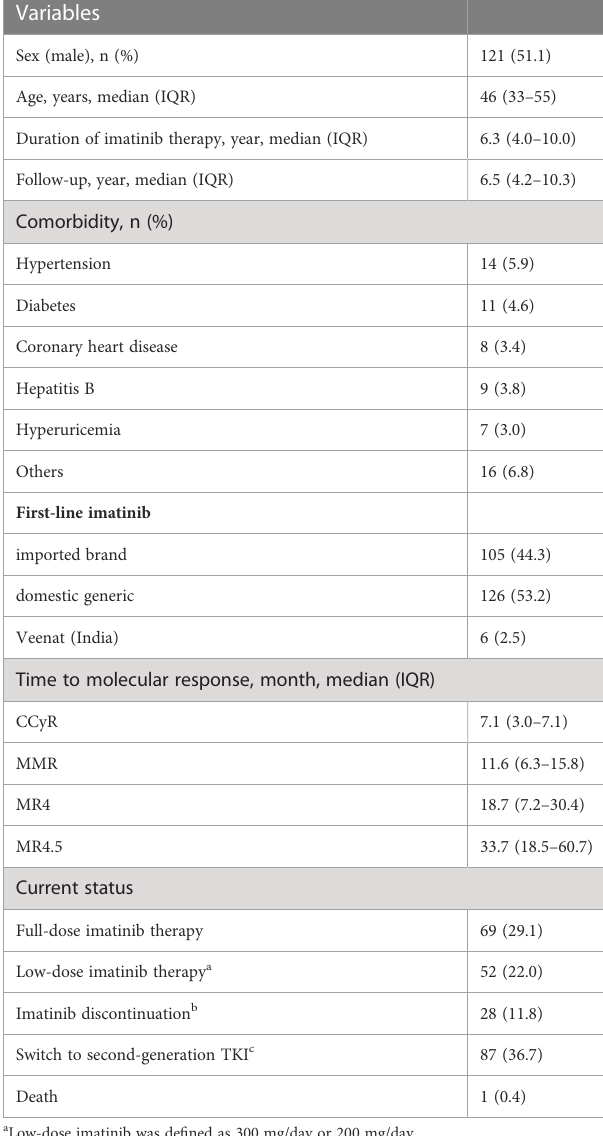
TABLE 1 Demographic and clinical characteristics of patients with chronic myeloid